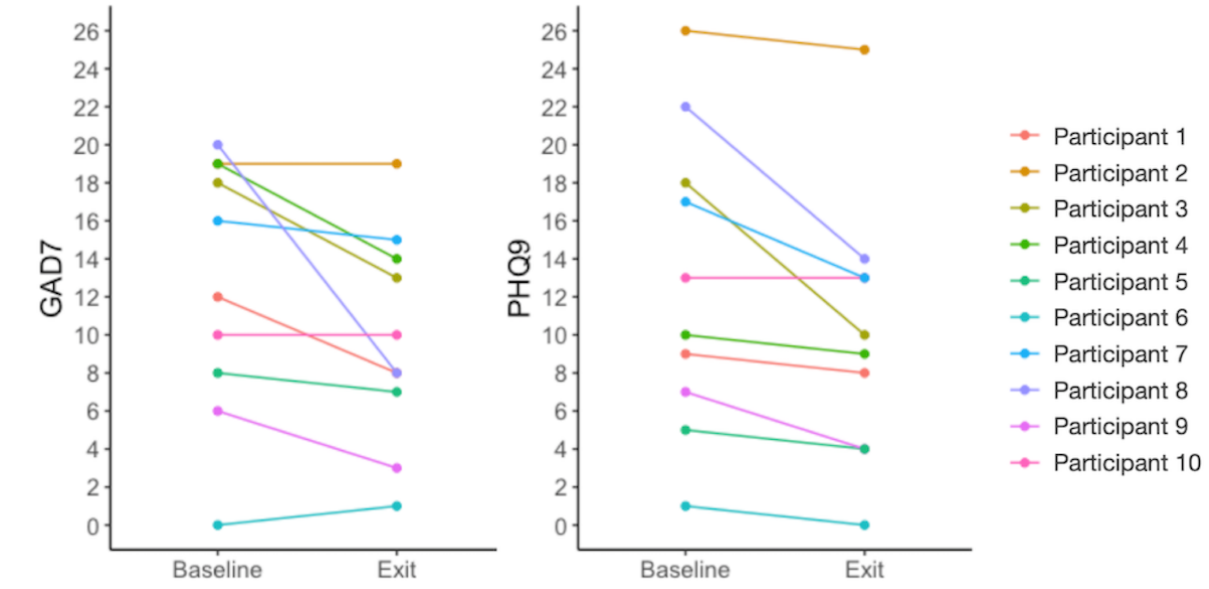
Figure 3. GAD-7 and PHQ-9 results in participants (N=10) of the digital intervention. The clinical cutoff for moderate anxiety or depression, respectively, is